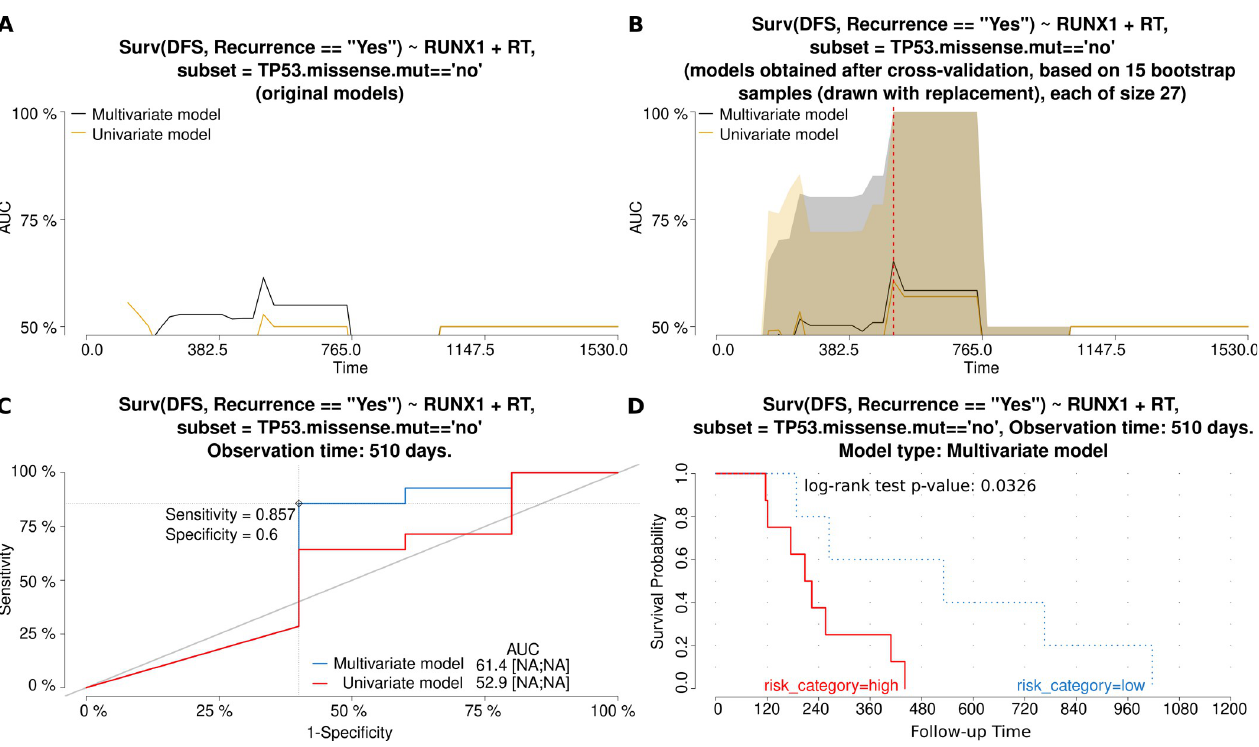
Fig 3. Characteristics and comparison of the Cox regression models (gene: RUNX1 ). The models allowed for the assessment of the risk of tumor recurrence , depending on either a single independent variable ( RUNX1 mRNA expression (exp)–the univariate model or three independent variables (exp, FIGO and RT)– the multivariate model. Fig A and B show how the AUC values (and thus also discriminating abilities of each model) change in time for original models (A) and models obtained after a bootstrap-based cross-validation of the original data set (B). The bigger the AUC, the higher the performance of a model. A red dashed line marks the same time point which was used to draw the time-dependent ROC curve (C) for both models. In Fig C, an optimal cut-off point was calculated for the multivariate model based on the Youden index. Sensitivity and specificity for this cut-off point are also provided. In addition, AUC values [%] are listed alongside the 95% CI values, shown in square brackets, if calculable. Fig D depicts the Kaplan-Meier survival curves obtained for the multivariate model at the same time point as in the remaining plots. The risk was classified as either higher (high) or lower (low) than in the cut-off point. The Kaplan- Meier curves are supplemented with the result of the log-rank test, as well. Abbreviations used: DFS–Disease-Free Survival, RT–Residual